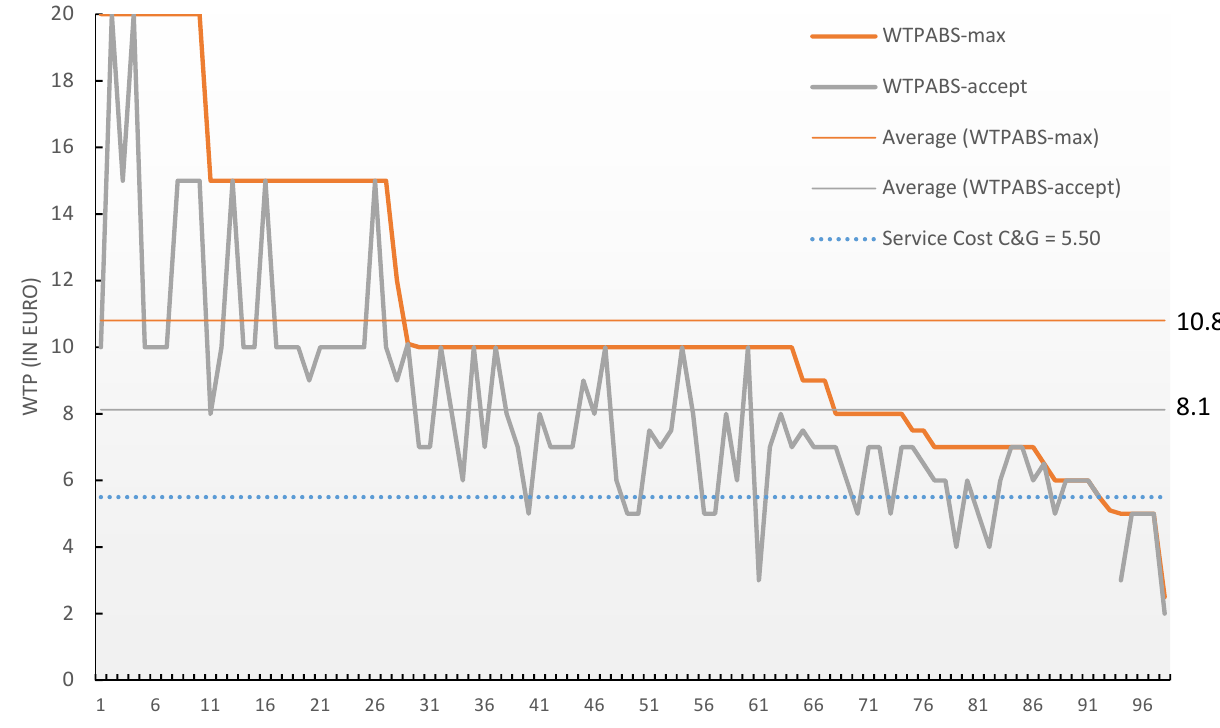
Figure 3. WTPABS for the users, in descending order.